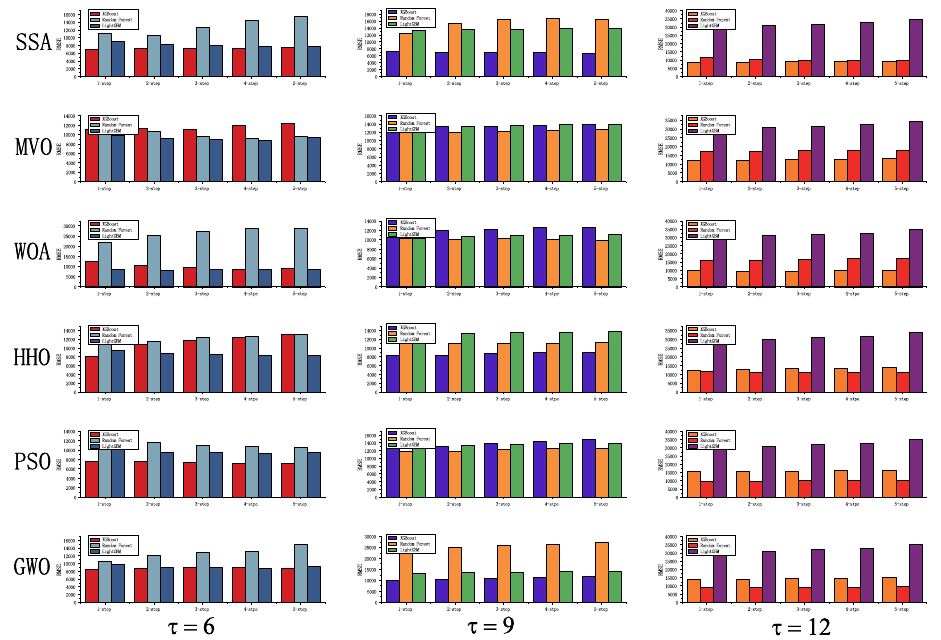
Figure 16. RMSEs of XGBoost, Random Forest and LightGBM with multi-step ahead forecasting steps for the Netherlands